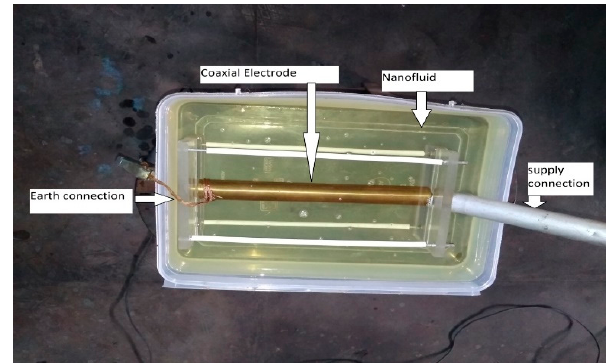
Figure 6. Electrode dipped in the insulating oil and the supply connection to the